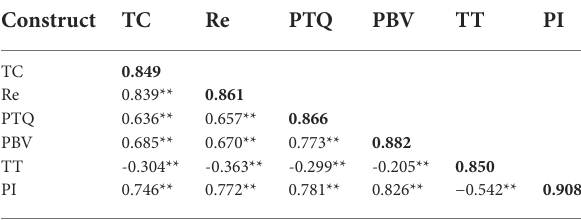
TABLE 4 Correlations of the latent variables and